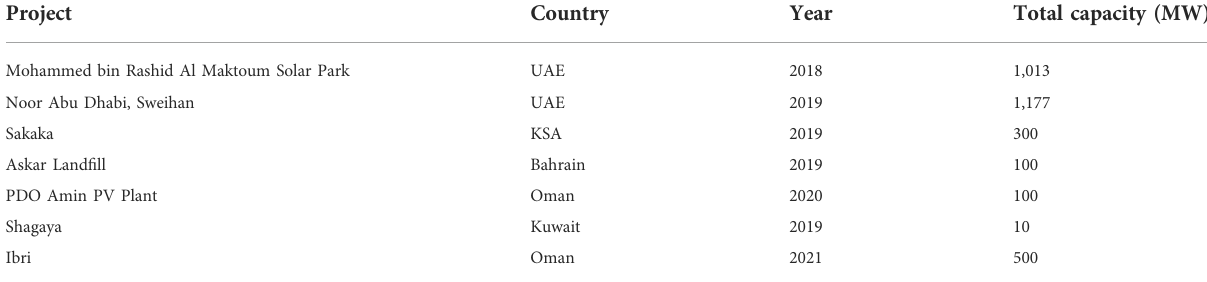
TABLE 1 PV solar projects operated in the GCC